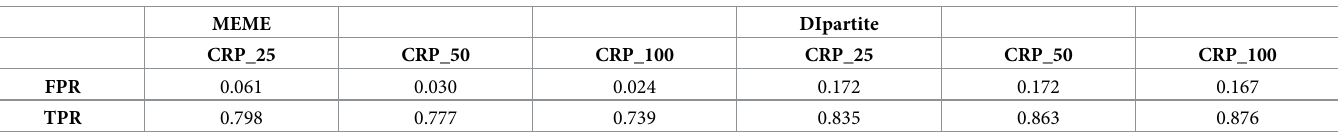
Table 1. The performance of noise detection for the one-block motif. MEME DIpartite CRP_25 CRP_50 CRP_100 CRP_25 CRP_50 CRP_100 FPR 0.061 0.030 0.024 0.172 0.172 0.167 TPR 0.798 0.777 0.739 0.835 0.863 0.876